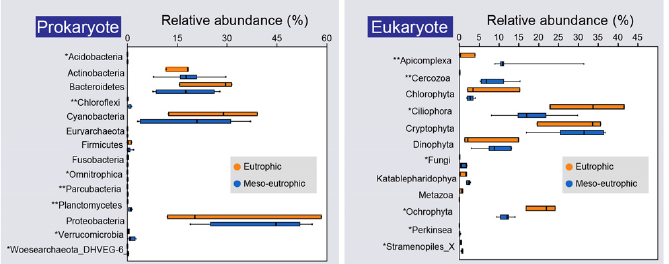
Figure 4. The comparisons for relative abundances of taxonomic groups from eutrophic region and meso-eutrophic region for prokaryotes and eukaryotes, respectively. The value of mean relative abundance higher than 0.1% of taxonomic groups were shown. The significance based on Wilcoxon test. Significant codes: ** P < 0.01; * P <